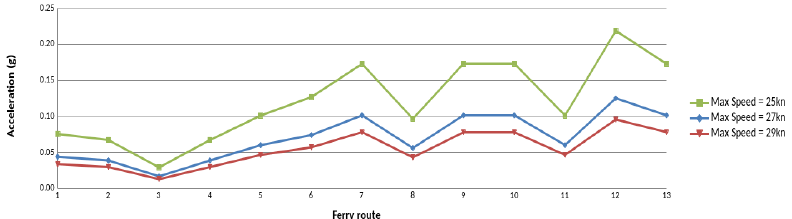
Figure 4. Required acceleration profile for different maximum speeds and prespecified travel plan [20].